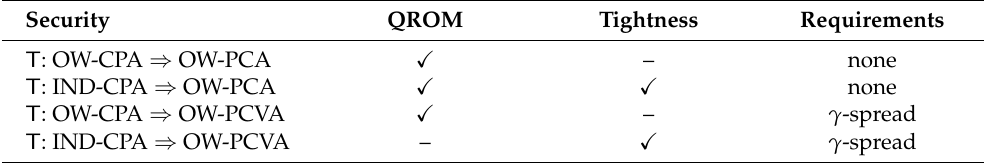
Table 2. Security reductions proven in [5] for the T transformation.